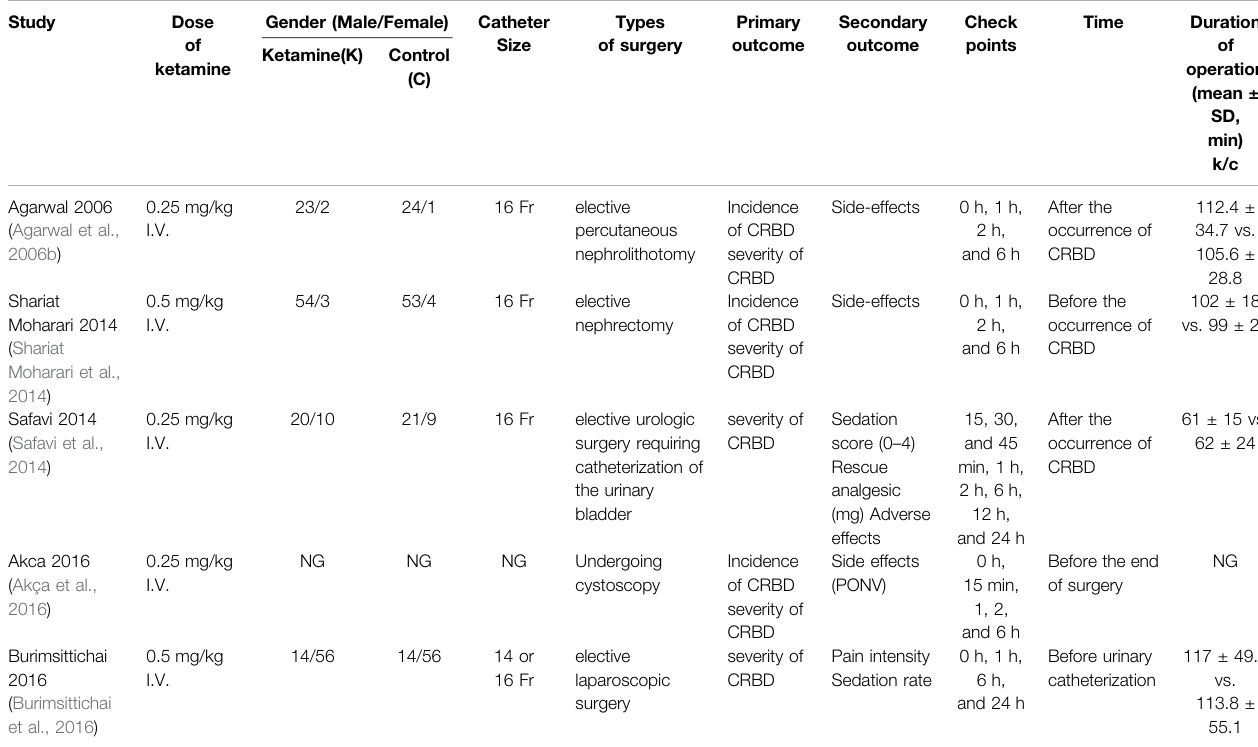
TABLE 1 | Characteristics of included